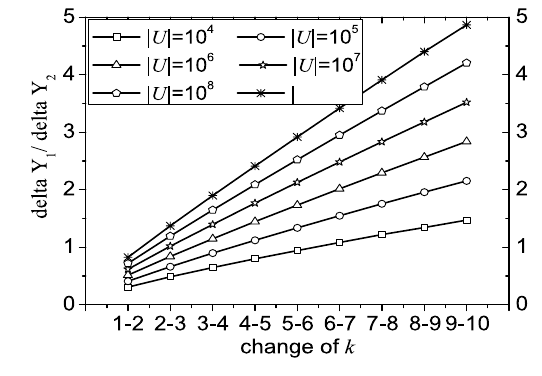
Fig. 5 Illustration of the change of △ Y 1